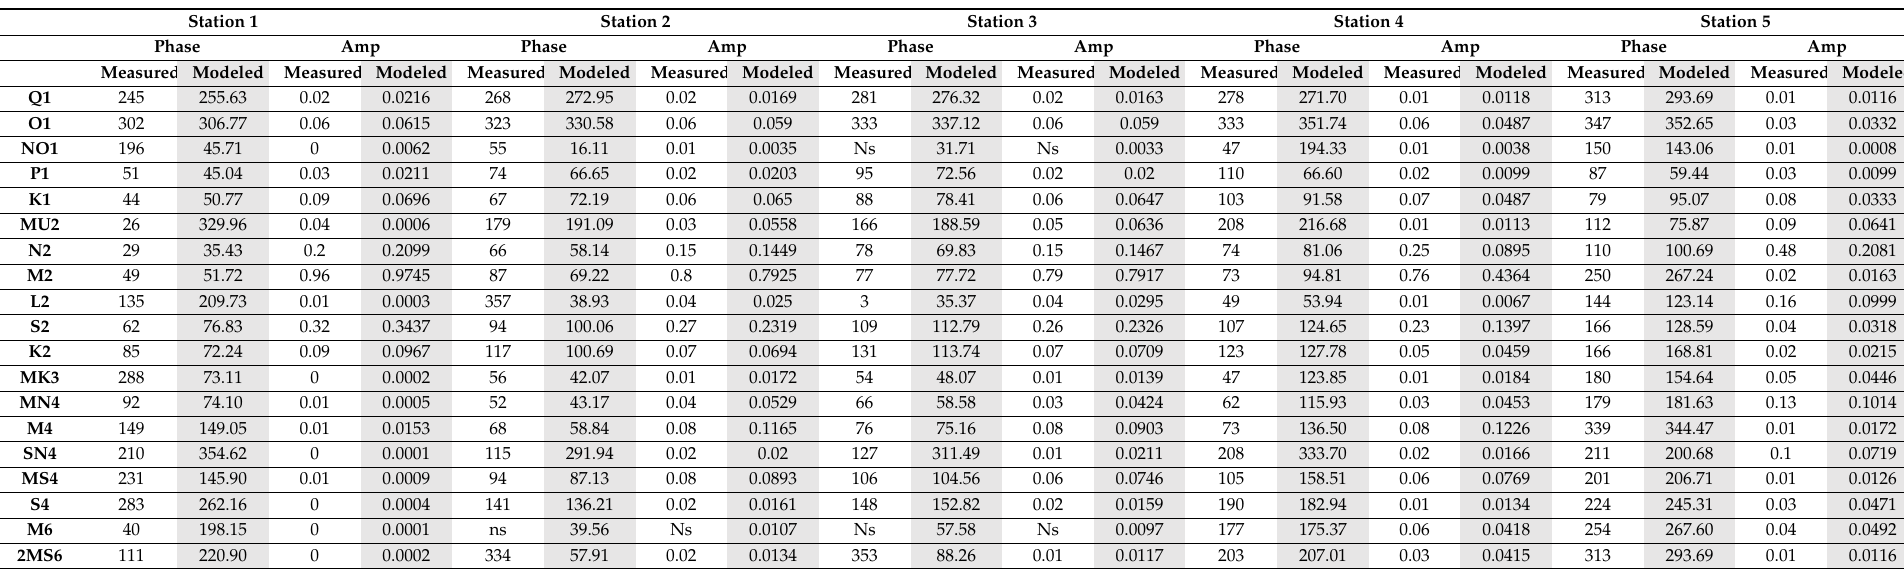
Table A1. Modeled and observed comparison for phase and amplitude in station 1, 2, 3, 4, and